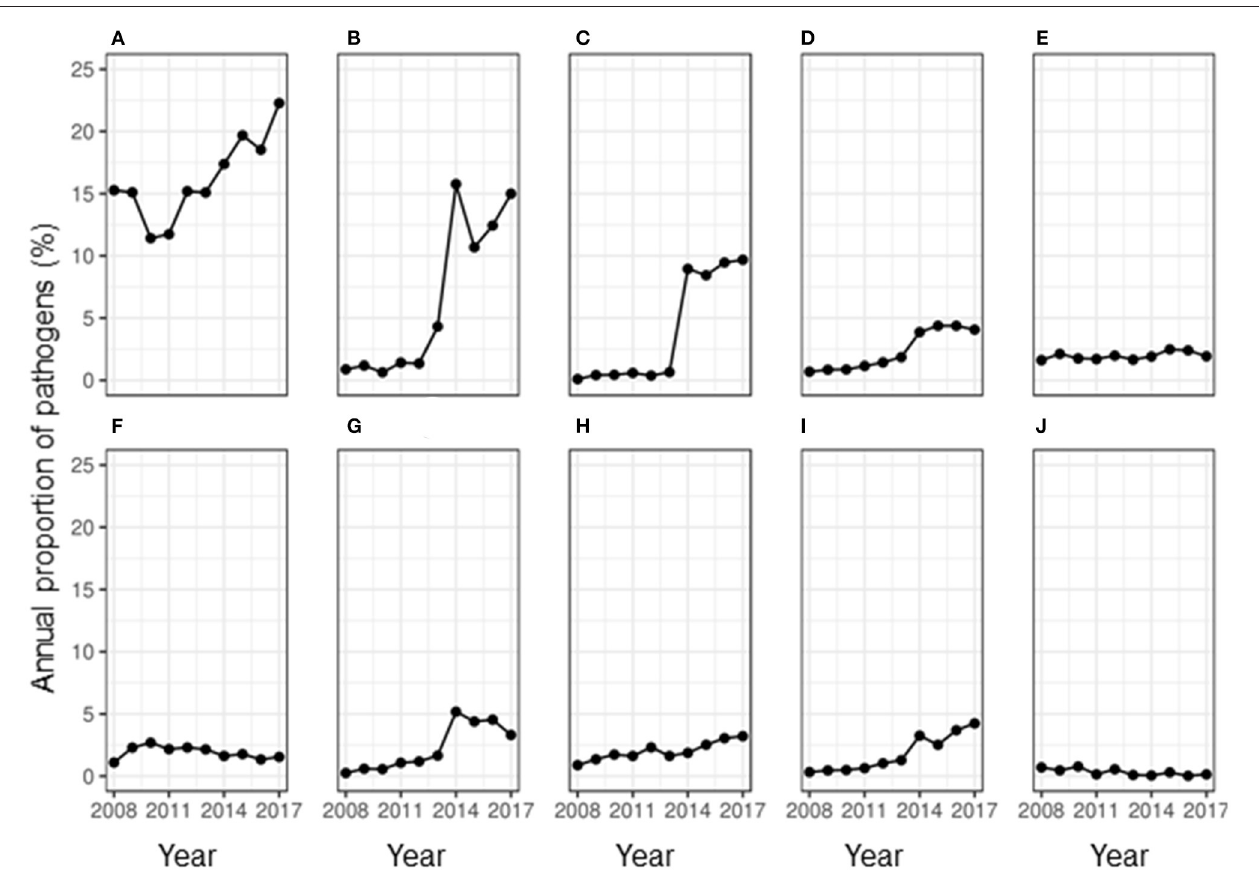
FIGURE 2 | Annual proportion of major mastitis pathogens isolated from 85,988 milk samples between 2008 and 2017 in Ontario, Canada. (A) Staph. aureus , (B) non-aureus Staphylococci, (C) Corynebacterium spp., (D) E. coli , (E) Trueperella pyogenes , (F) Algae, (G) Streptococcus uberis , (H) Fungus, (I) Strep. dysgalactiae , and (J) Streptococcus agalactiae